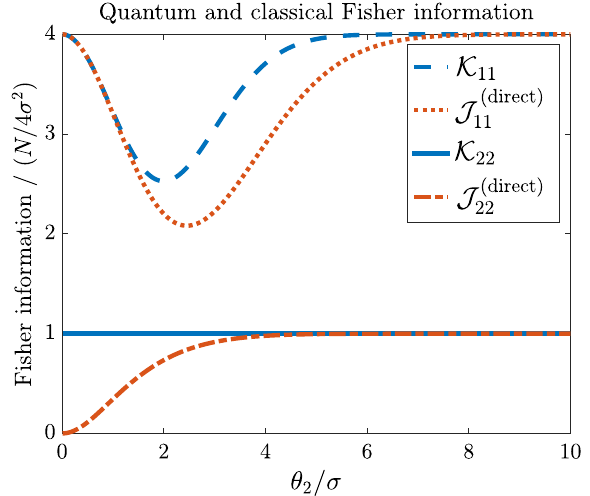
2. Plots of Fisher information versus the separation for a Gaussian point-spread function. K 11 and K 22 are the quantum values for the estimation of the centroid θ 1 ¼ ð X 1 þ X 2 Þ = 2 and the separation θ 2 ¼ X 2 − X 1 , respectively, while J ð direct Þ 11 and J ð direct Þ 22 are the corresponding classical values for direct imaging. The horizontal axis is normalized with respect to the point-spread function width σ , while the vertical axis is normalized with respect to N= ð 4 σ 2 Þ , the value of K 22